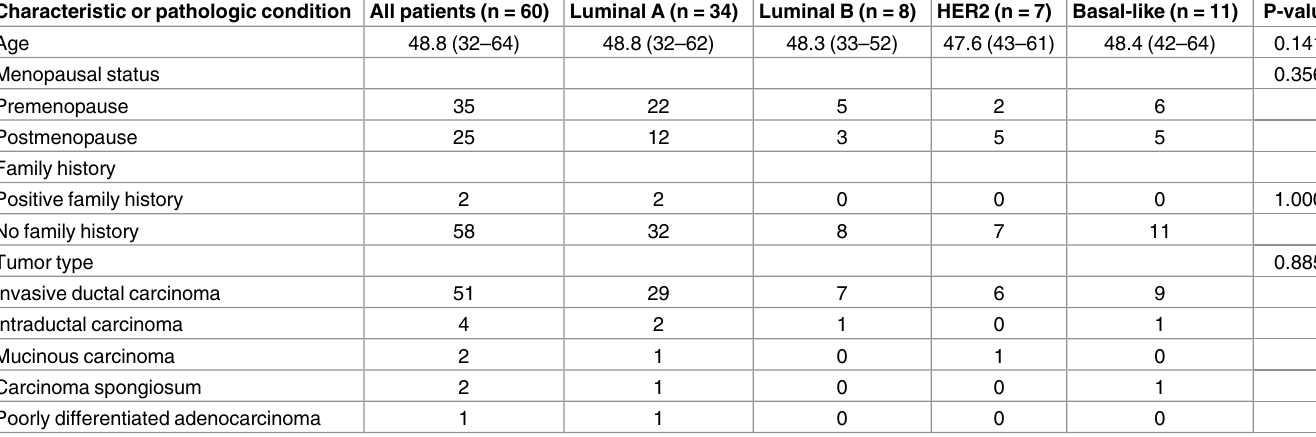
Table 2. Characteristics of the molecular subtypes of